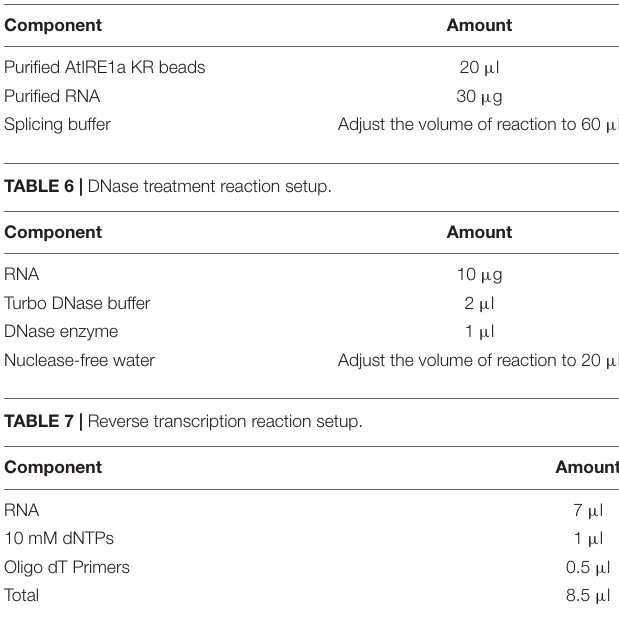
TABLE 5 | In vitro AtIRE1a-dependent mRNA cleavage assay setup.